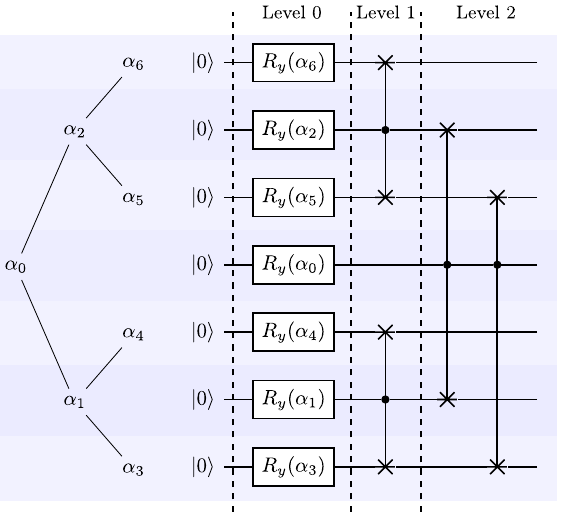
Figure 4. Rotated angle-tree and a circuit generated by the divide-and-conquer strategy described in Algorithm 3. The quantum bit q [ k ] in the circuit is aligned with the angle α [ k ] in the angle-tree, this organization allows to draw the quantum gates in each layer in parallel. In this example, the desired state is stored in qubits q [0], q [1] and q [3] to generate the quantum state with entangles ancilla as in Eq.